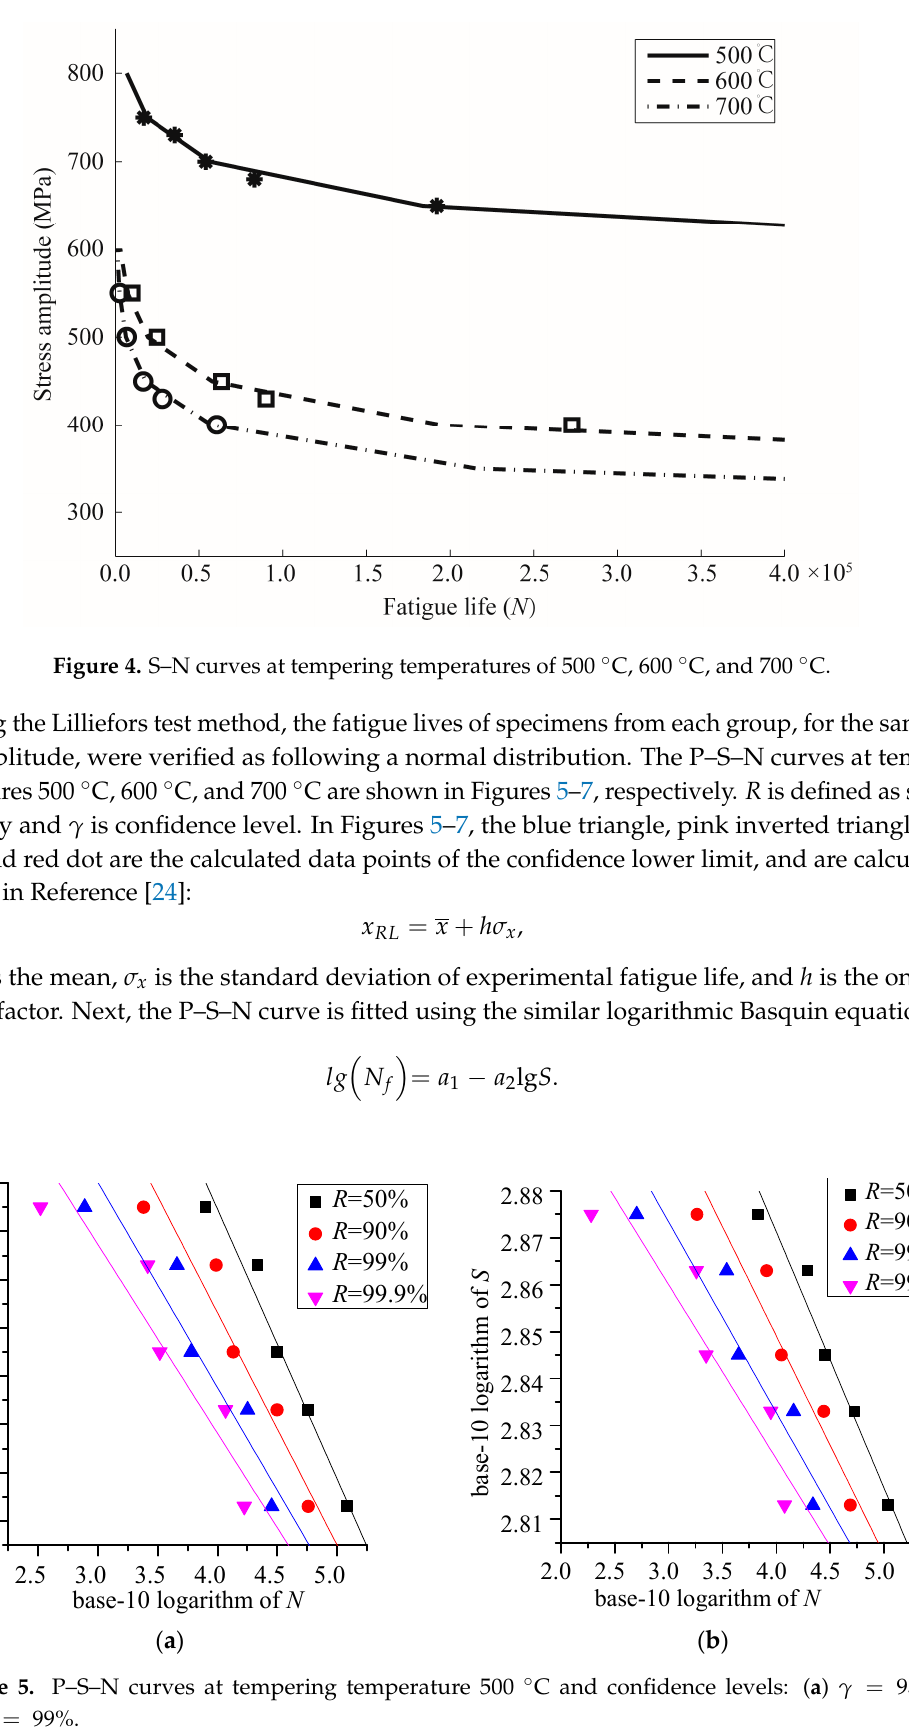
( b ) Figure 6. P–S–N curves at tempering temperature 600 °C and confidence levels: ( a ) (cid:2011) = 95% ; ( b ) (cid:2011) = 99% . 2.602.622.642.66 2.68 2.702.722.742.76 1.5 2.0 2.5 3.0 3.5 4.0 4.5 R =50% R =90% R =99% R =99.9% base-10 logarithm of N f b a s e - 10 l og a r i t h m o f S ( b ) Figure 7. P–S–N curves at tempering temperature 700 °C and confidence levels: ( a ) (cid:2011) = 95% ; ( b ) (cid:2011) = 99% .